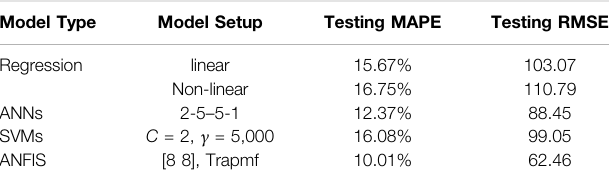
TABLE 6 | Summary of model validation